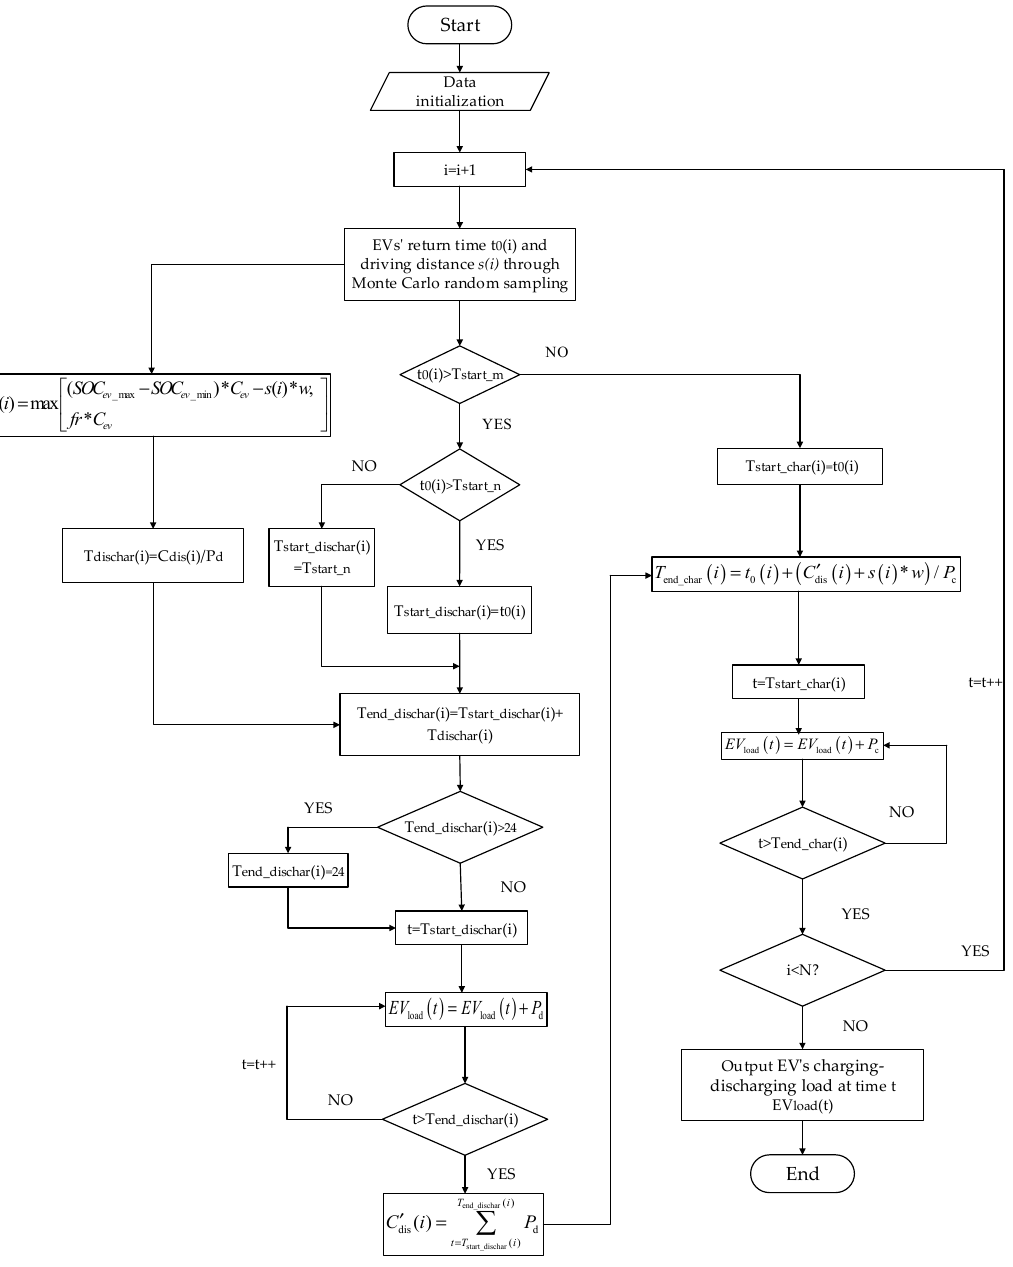
Figure 4. A flow chart of dispatching strategy of EVs at the load level.